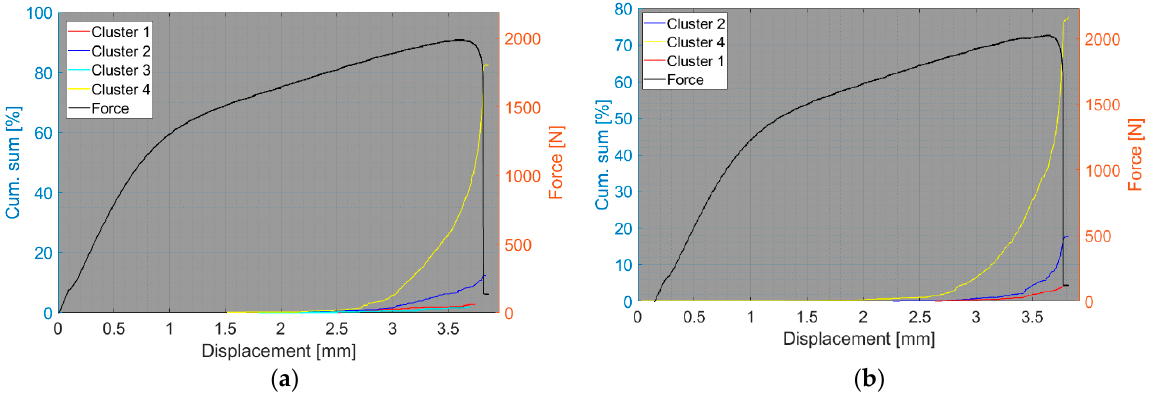
Figure 26. Cumulative sum of hits of individual clusters, including force versus displacement—CPTS samples: ( a ) Fujicera 1045S dataset; ( b ) DWC 454 dataset.